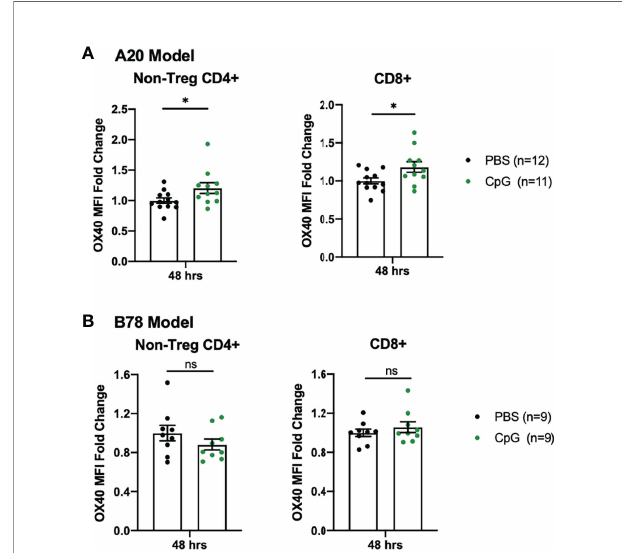
FIGURE 2 | B78 and A20 Tumor Models Demonstrate Differences in Response to CpG Treatment. (A) OX40 MFI fold change expression on non- Treg CD4+ or CD8+ tumor in fi ltrating T cells in the A20 model 48 hours after treatment with PBS (black) or CpG (green). (B) OX40 MFI fold change expression on non-Treg CD4+ or CD8+ tumor in fi ltrating T cells in the B78 model 48 hours after treatment with PBS (black) or CpG (green). The data plotted here are the results from two independent experiments (n=4-6 per group, per experiment). Average OX40 MFI values in the PBS cohort were calculated for each separate experiment, then used to determine fold-change differences for each sample from that particular experiment. Each symbol represents the MFI fold change from one mouse. Flow gating strategy is presented in Supplementary Figure 3 . P values were calculated using Mann-Whitney tests. *P ≤ 0.05; NS, nonsigni fi